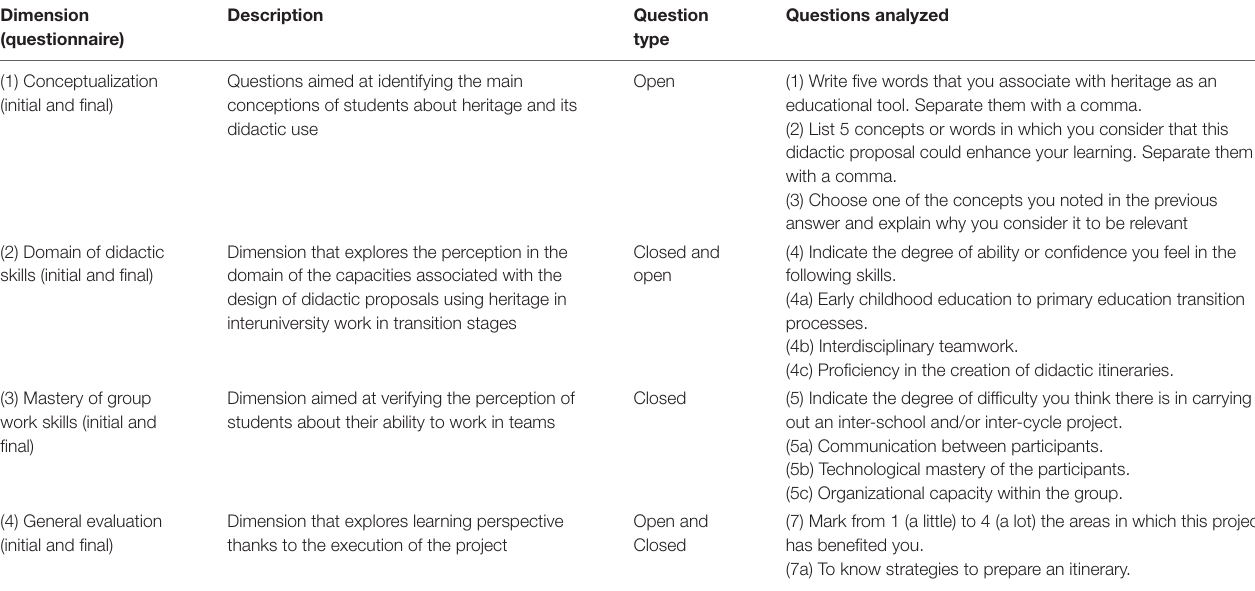
TABLE 3 | Table of specifications of the questions analyzed in the initial and final questionnaire. Dimension